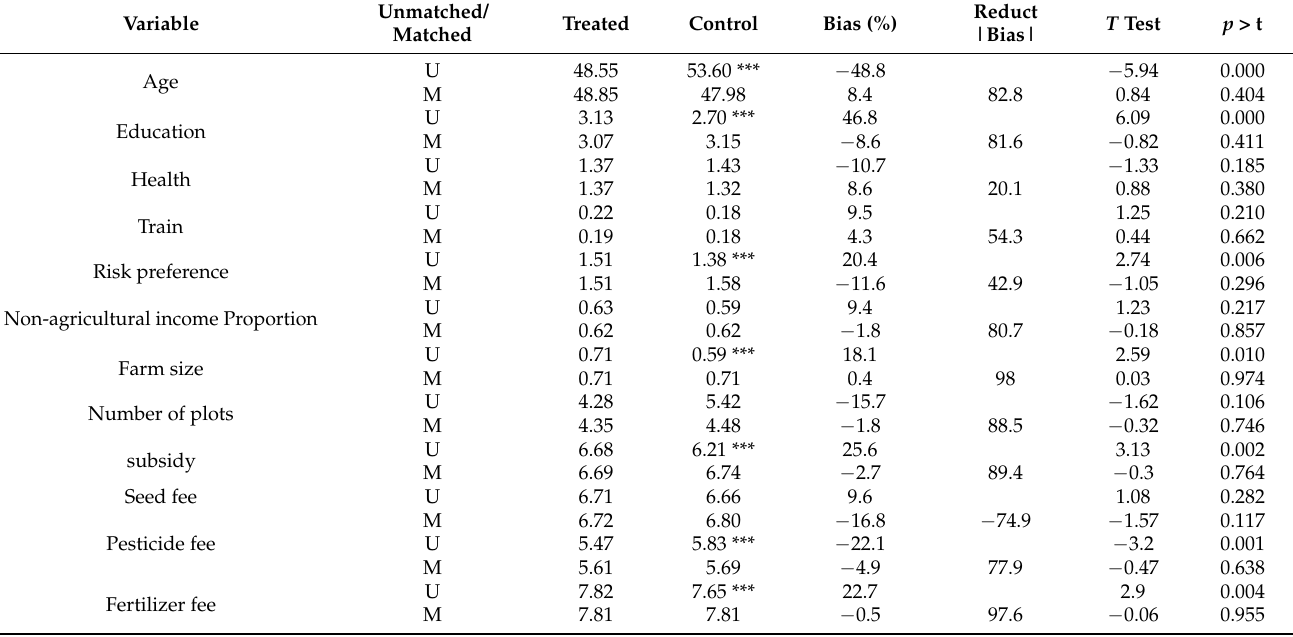
Table 5. Balance test of the PSM